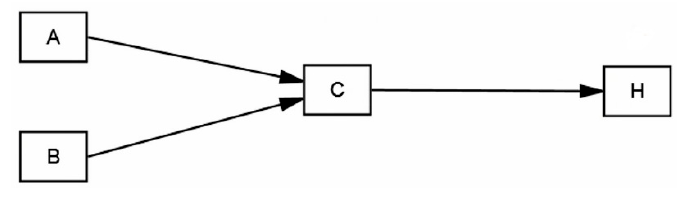
Figure 7. SEM analysis method.